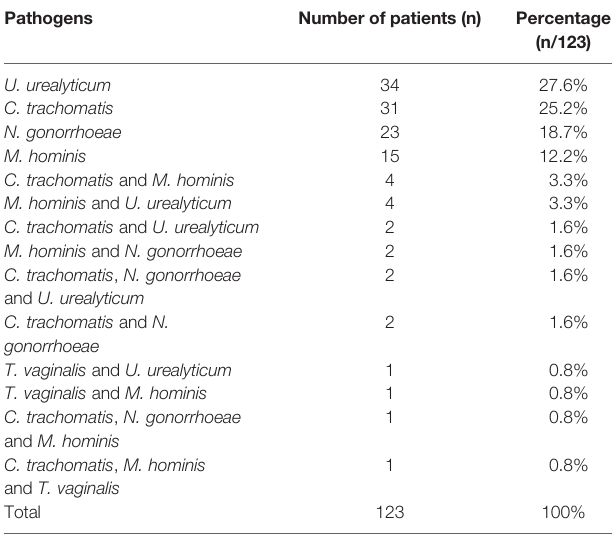
TABLE 3 | The distribution of pathogens detected in 123 patients by STI- HMGS.